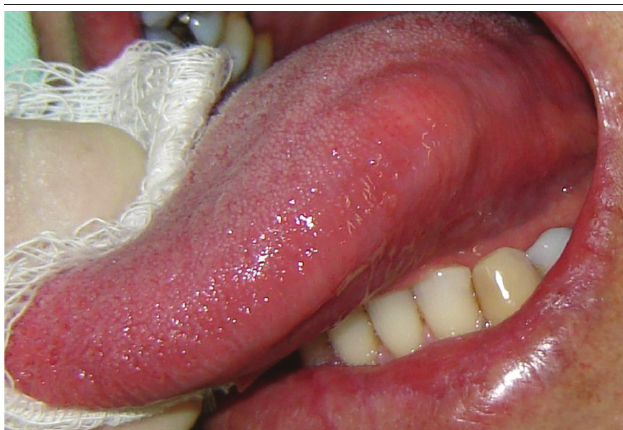
BA CD34 20×S100 figurE 3 − Positive immunohistochemical staining for S100 protein (A) and CD34 (B)